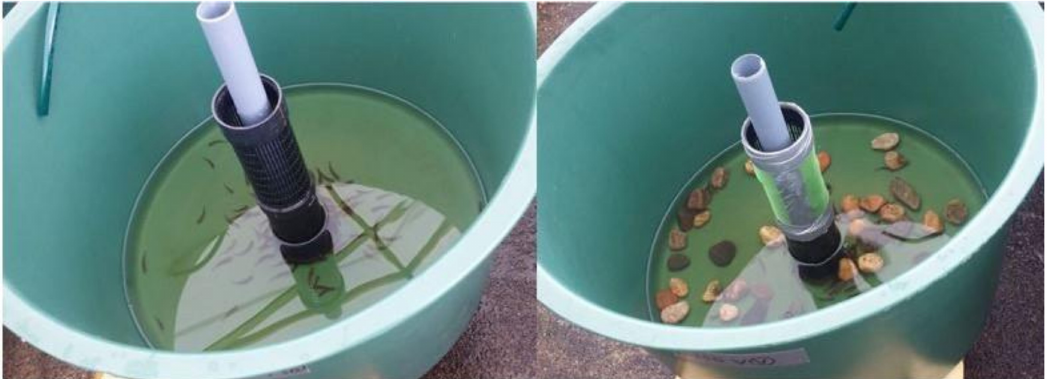
Figure 2. Standard and enriched tanks used in the experimental bacterial exposures. Replicated tanks with no stones ( left panel), few stones (6 stones) or many stones (60 stones, right panel) were used. In addition, stones were either clean, unconditioned or conditioned in lake water before the experiment. Each tank (0.4 m 2 ) had 100 fish (either trout or salmon) and 60 l of water (16.5–18.9 ◦